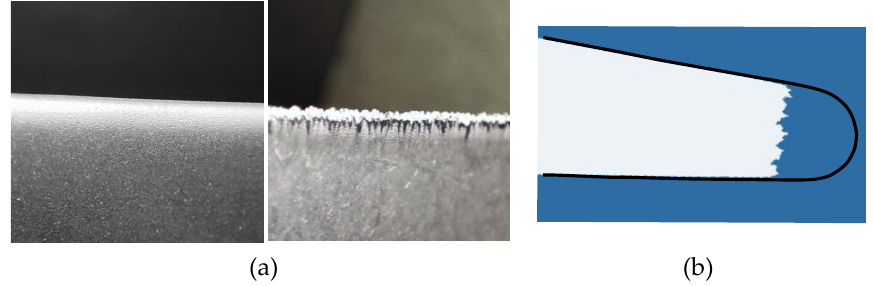
Figure 2. Fan blade leading-edge morphology: ( a ) Reference (left) and worn (right) leading edge; ( b ) leading edge erosion with loss of chord length.